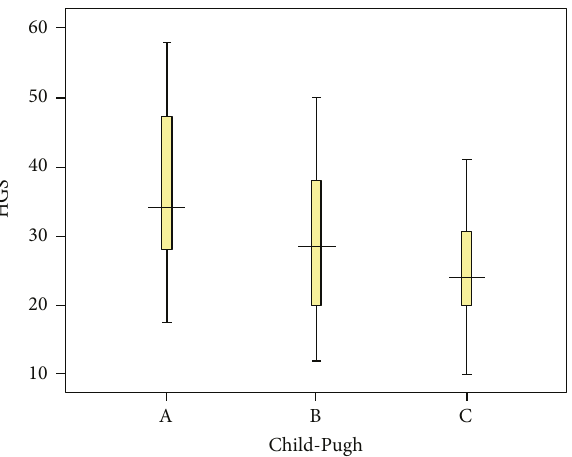
Figure 1: HGS mean and con fi dence interval distribution among Child-Pugh classes.